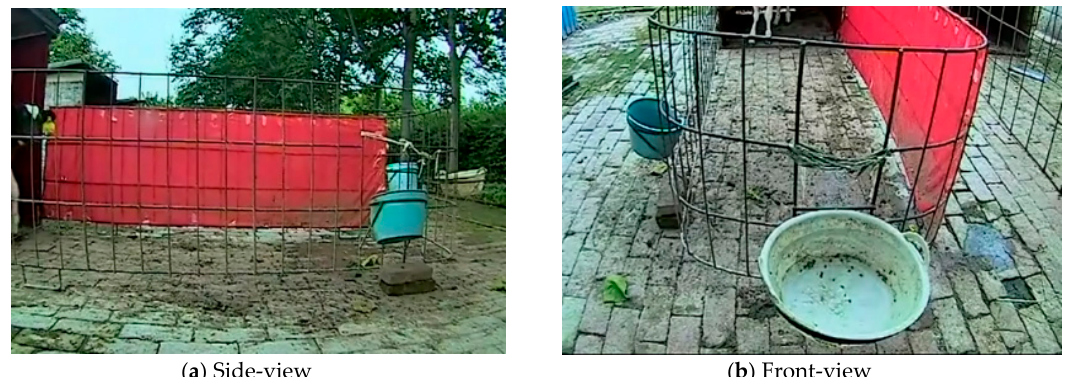
Figure 2. Test site. Red canvas was used to reduce background interference to side-view.